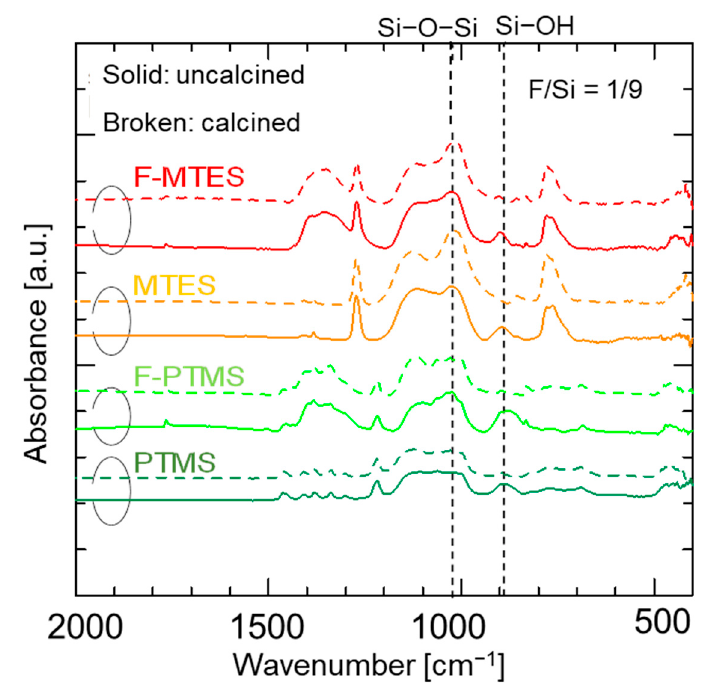
Figure 6. FT–IR spectra of fluorine–doped (F–MTES, F–PTMS) and undoped (MTES, PTMS) pendant–type organosilica films before/after calcination at 300 °C under a N 2 atmosphere.